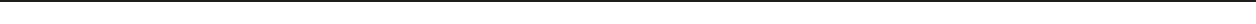
Fig. 7 SHARP1 interacts with MLL-AF6 and regulates gene targets. a Enriched gene sets in ML-2 shGFP cells over shSHARP1 on RNA-seq. b Venn diagram showing overlapping of SHARP1-bound genes with MLL-AF6 target genes (MLL N + H3K79me2) in ML-2 cells. c Heatmap images representing the relative expression levels of 14 MLL-AF6/SHARP1 co-target genes downregulated upon SHARP1 knockdown obtained from RNA-seq data. d Genome view of MLL N , MEN1, LEDGF, H3K79me2, H3K79me3, and SHARP1 peak binding on three MLL-AF6 + SHARP1 target genes in ML-2 shGFP: MEF2C , CDK6 and RUNX2 gene. e Co-immunoprecipitation studies of SHARP1 and MLL-AF6 with an anti-HA antibody in 293 T cells transfected with plasmids encoding MLL- AF6 and/or HA-tagged SHARP1. Proteins present in immunoprecipitates (IP, lane 1 – 4) or whole cell lysates of transfected cells (input, lane 5 – 8) were separated by SDS-PAGE and immunoblotted with antibodies speci fi c for MLL N and SHARP1. Interaction of SHARP1 and MLL-AF6 was detected (lane 4) and not observed in negative control lanes with either empty vector, SHARP1 or MLL-AF6 only (lane 1 – 3). f Schematic showing a series of MLL deletion mutants. Interaction with SHARP1 is indicated by + sign and loss of interaction by − sign. Boxes indicate AT hook motifs (blue), nuclear translocation sequences (NTS1 and NTS2) (orange), subnuclear localization domains (SNL1 and SNL2) (purple), and DNA methyltransferase domain (MT) (yellow). g Domain mapping analysis of MLL required for interaction with SHARP1. 293 T cells are transfected with plasmids encoding FLAG-tagged MLL deletion mutants and HA-tagged SHARP1. Whole cell lysates were prepared from the transfected cells and subjected to immunoprecipitation with anti-FLAG antibody. Proteins present in immunoprecipitates (IP, lane 1 – 7) or whole cell lysates of transfected cells (input, lane 8 – 14) were separated by SDS-PAGE and immunoblotted with antibodies speci fi c for FLAG-tagged MLL deletion mutants and HA-tagged SHARP1. The arrows indicate MLL mutant proteins. Western blots are representative of at least three independent